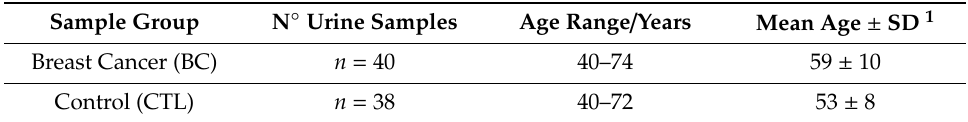
Table 1. List of collected urine samples from breast cancer patients and healthy individuals (controls). Sample